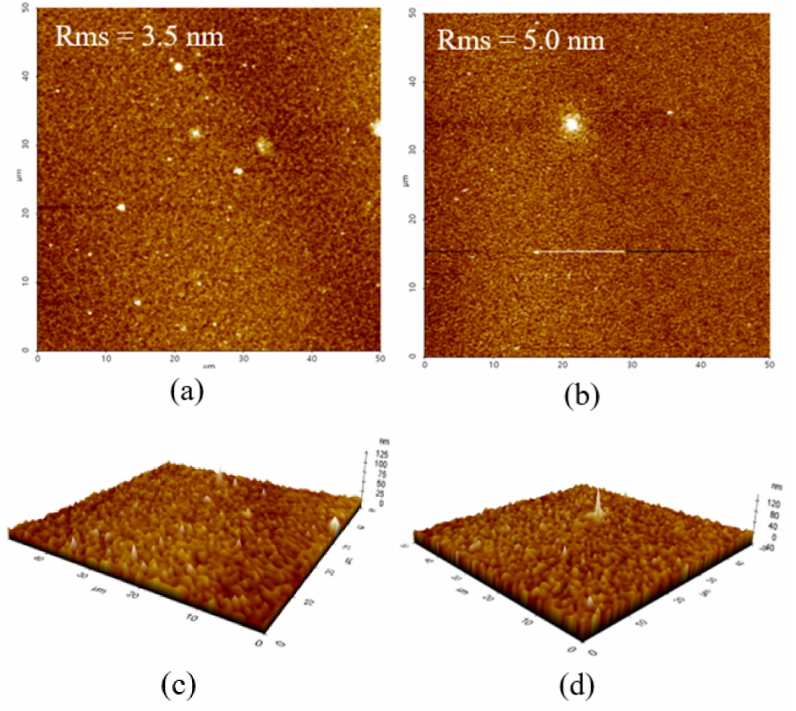
Figure 5. Atomic force microscopy (AFM) images of Ref-ZnO NPs and PVP-ZnO NPs on top of P3HT / PCBM photoactive layers: ( a ) Ref-ZnO film, ( b ) PVP-ZnO film. 3D AFM images of Ref-ZnO NPs and PVP-ZnO NPs on top of P3HT / PCBM photoactive layers: ( c ) Ref-ZnO film, ( d ) PVP-ZnO